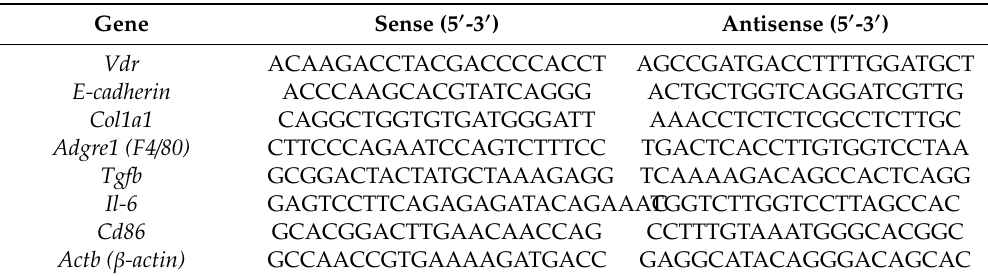
Table 3. Sequences of mouse primers used in real-time